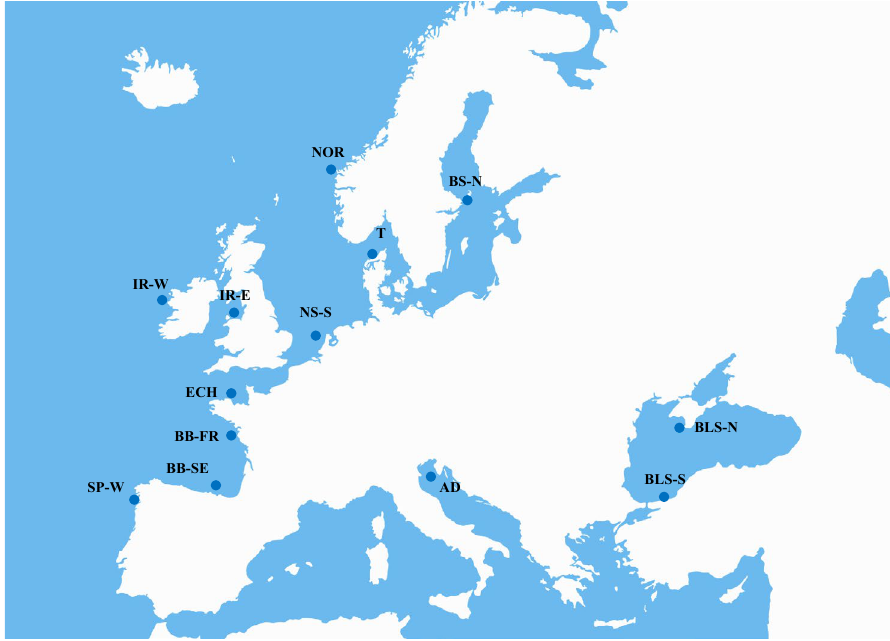
Figure 1. Sampling of wild turbot ( Scophthalmus maximus ) across its European distribution